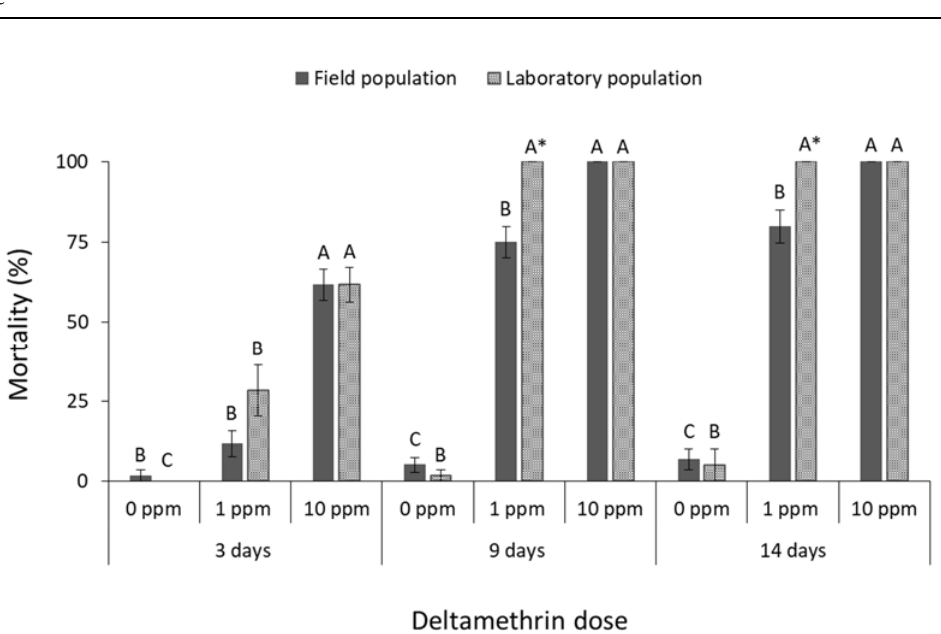
Figure 1. Mean (% ± SE) adult mortality of field and laboratory populations of R. dominica after 3, 9, and 14 days of exposure to different concentrations of deltamethrin (within each exposure interval and population, means followed by the same letter are not significantly different; where no letters are present, no significant differences were noted; HSD test a 0.05; within each exposure interval and dose, means with asterisk (*) indicate significant differences between the populations, according to Students’ t -test at p <